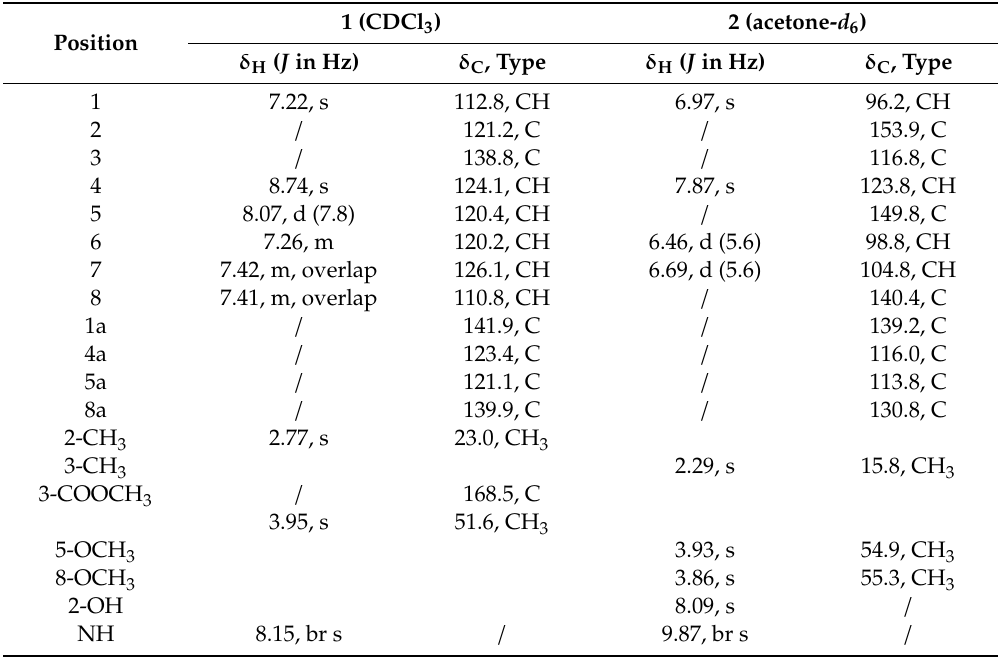
Table 1. 600MHz and 13 C NMR (150MHz) data of clauolenzoles A and B ( 1 , 2 ). 1 (CDCl 3 ) 2 (acetone- d 6 Position